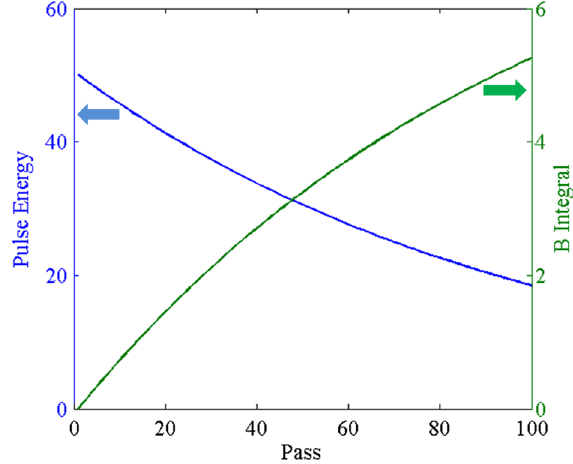
FIG. 18. Pulse energy and B -integral as a function of pass number in the ringdown cavity.